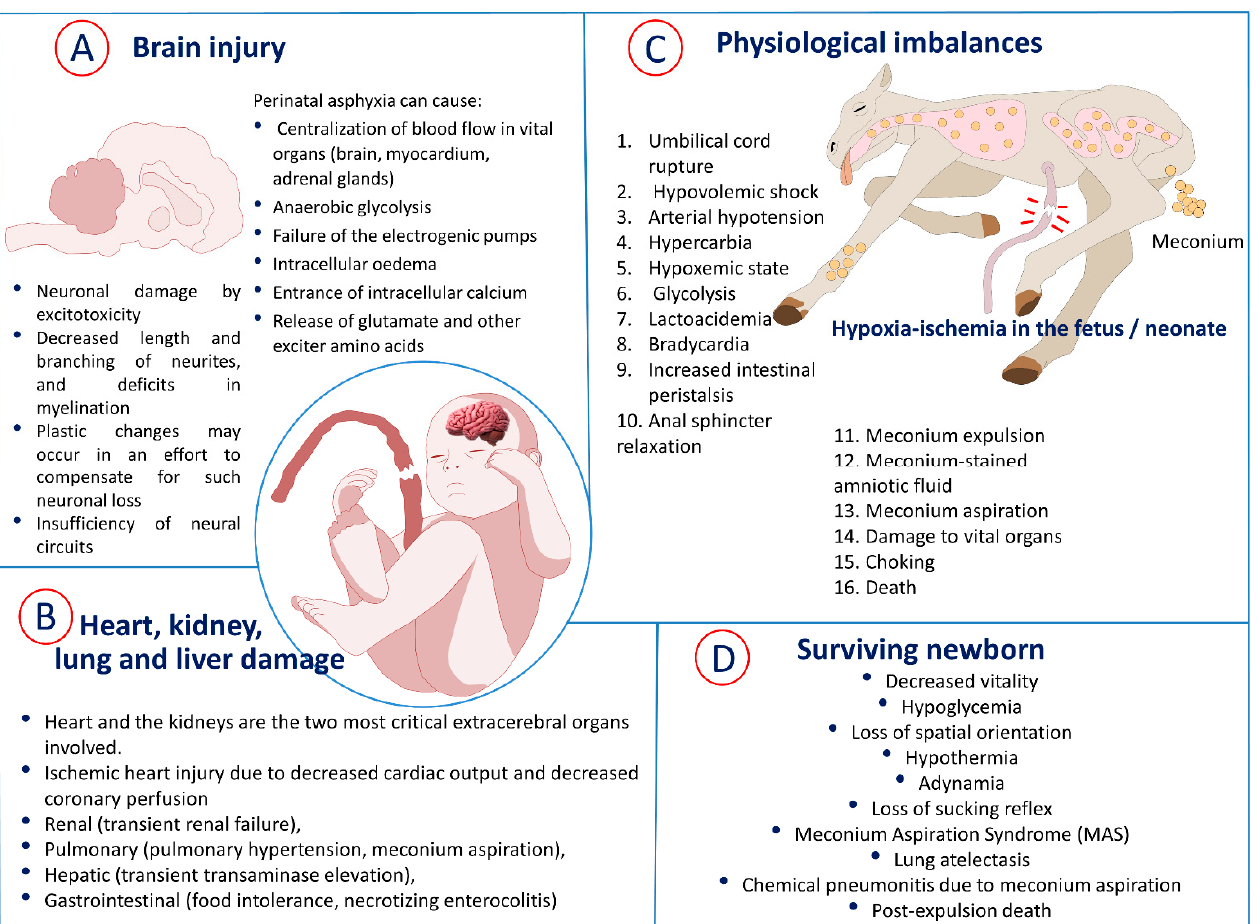
Figure 2. Fetal asphyxia in human and non-human animals, organ injury and physiological imbalances in response to hypoxia–ischemia. Image ( A ) summarizes the neuronal damage at a biochemical and pathological level. Image ( B ) shows damage in other vital organs. In image ( C ), the physiological imbalances are appreciated due to the drastic reduction of oxygen to the fetus, and promote the expulsion of meconium. In letter ( D ) some adverse effects if the newborn survives.